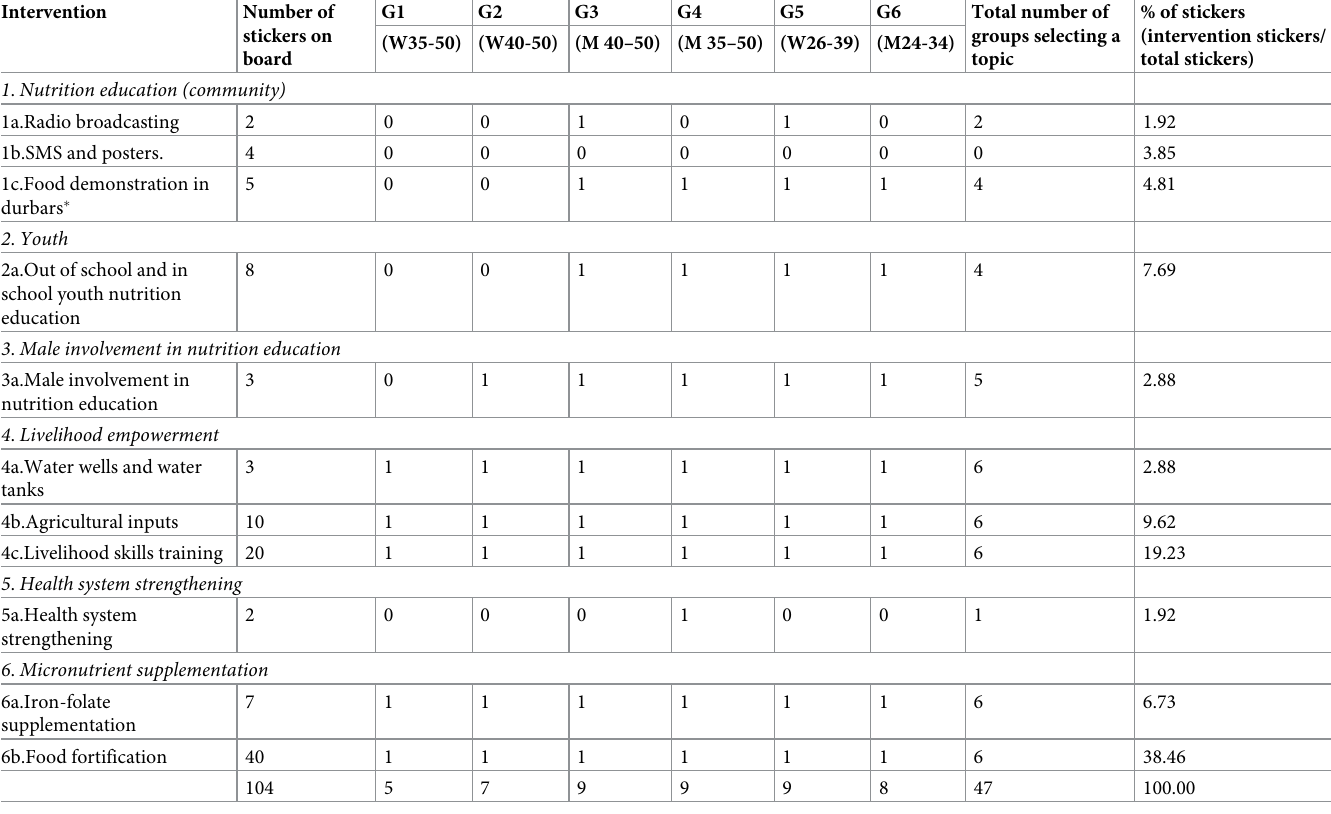
Table 3. Final group choices for each nutrition intervention.